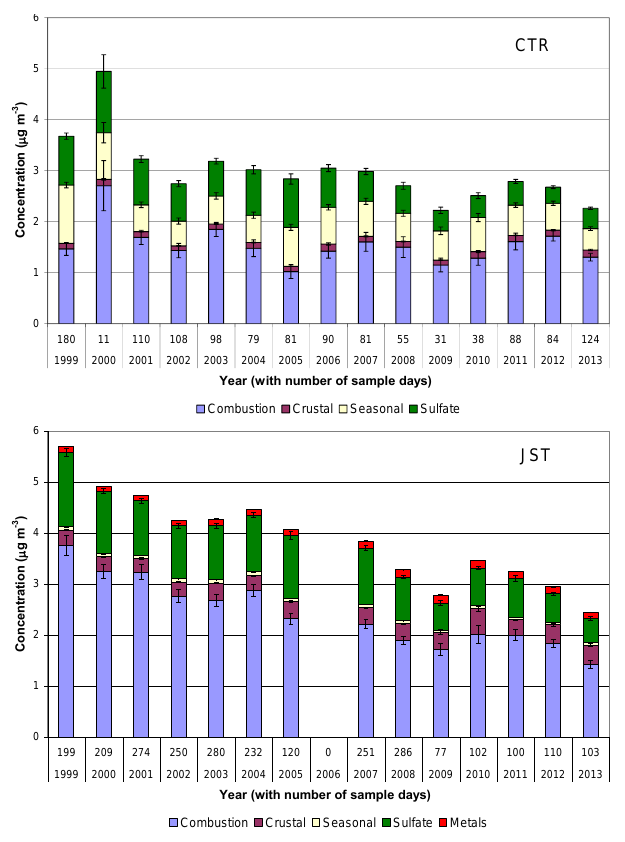
Figure 4. Trends in source contributions to OC at CTR and JST determined from PCA2 for